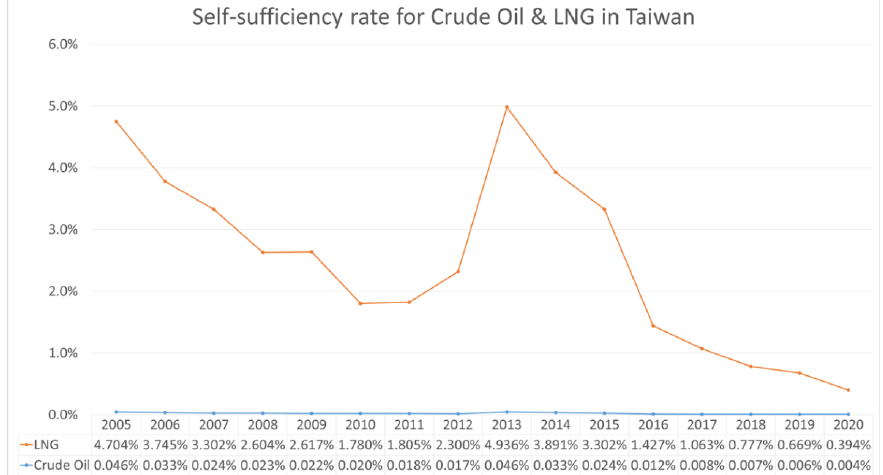
Figure 5. Self-sufficiency rate for crude oil and LNG in Taiwan 2005 – 2020. Source: Bureau of Energy, MOEA.